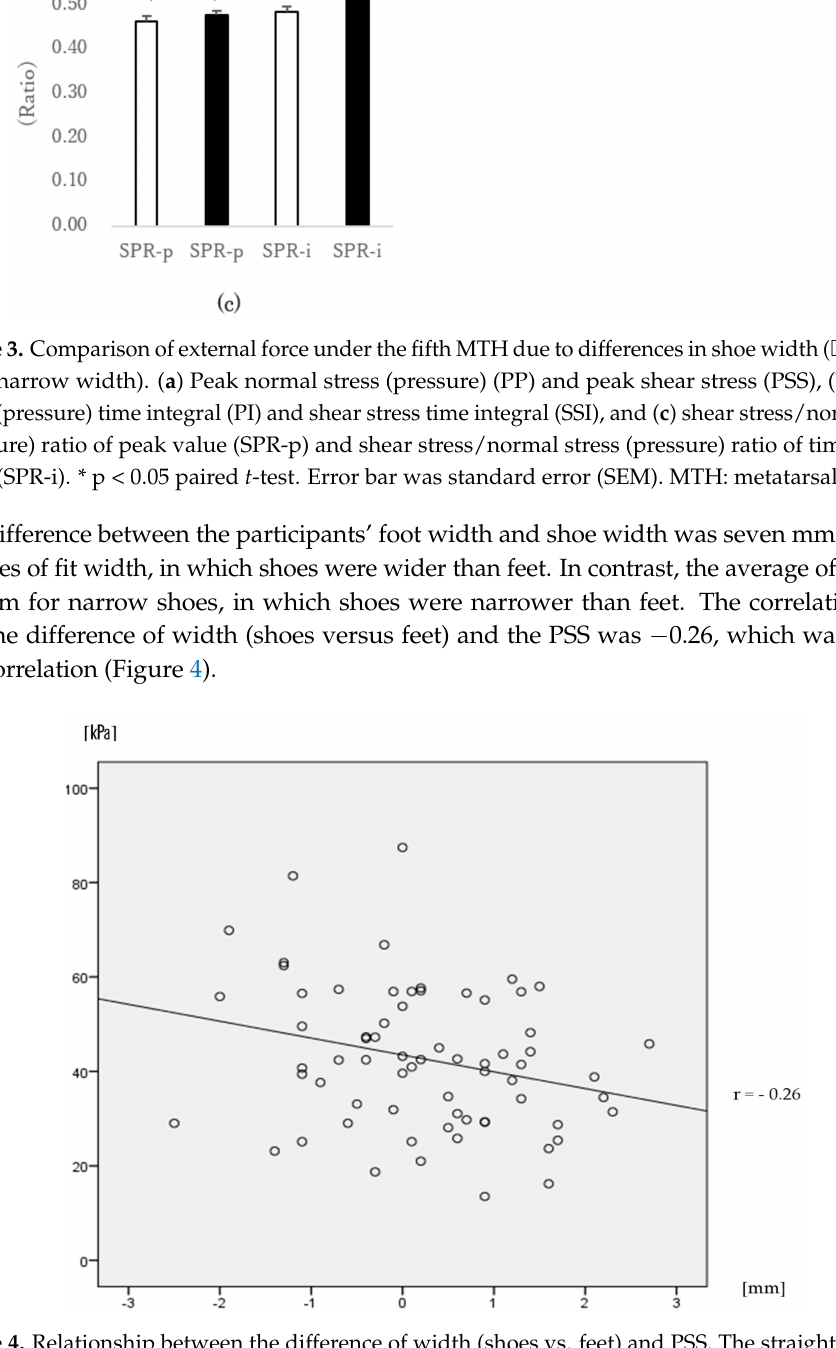
Figure 4. Relationship between the difference of width (shoes vs. feet) and PSS. The straight line is the correlation line. Dots are